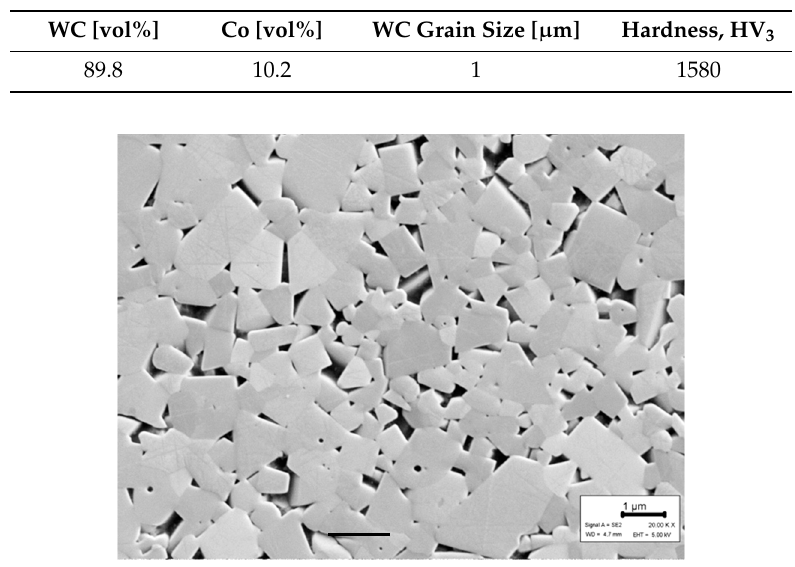
Figure 2. Microstructure of the cemented carbide grade investigated. WC phase appears bright, Co phase appears dark. Table 1. Chemical composition (in weight %) and hardness of the work-piece material Ti6Al4V according to the material specification provided by material supplier Timet.